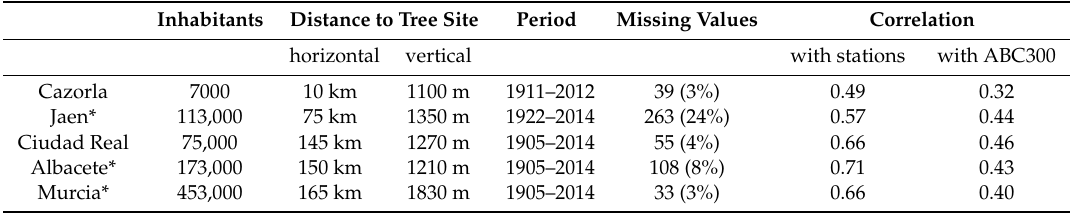
Table 2. Temperature stations in the surroundings of the CNP. Last two columns show the average correlations with all other stations, and with the ABC300 chronology using February–May and September–October (FMAM&SO) temperature